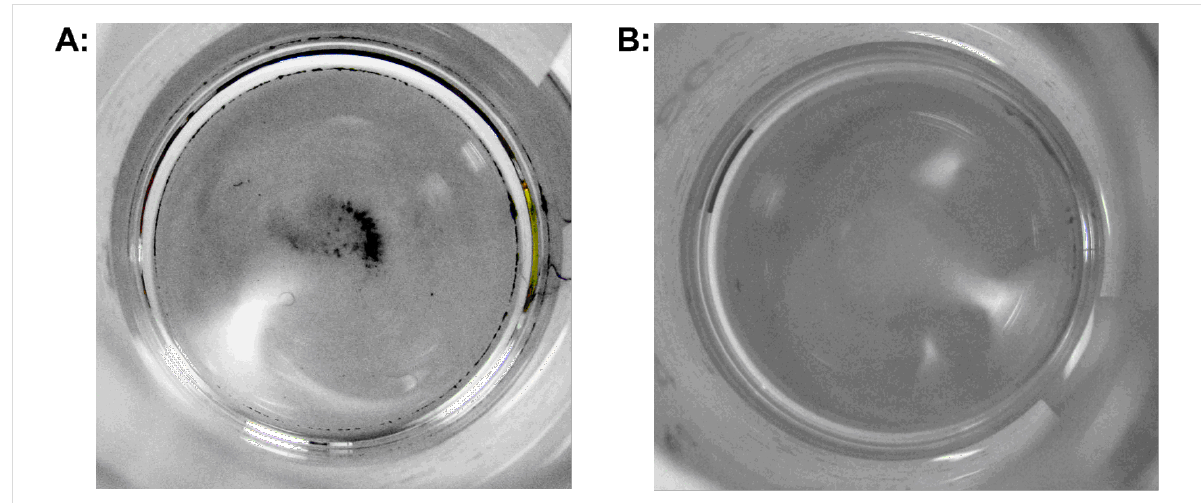
Figure 7: Leached catalyst from 30 mm 10% Pd/C CatCart ® . First 10 mL wash aliquot (A) compared to second 10 mL wash aliquot (B). Photographs were taken from above, with the samples in 20 mL scintillation vials.